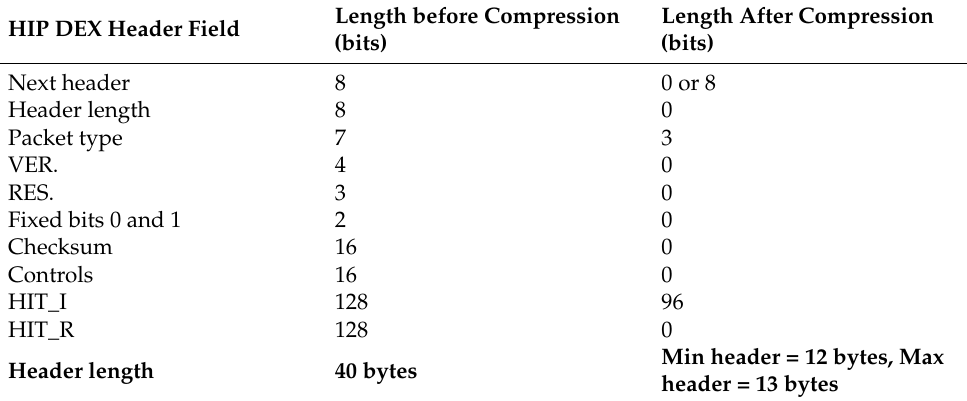
Table 2. HIP DEX header fields before and after proposed compression with